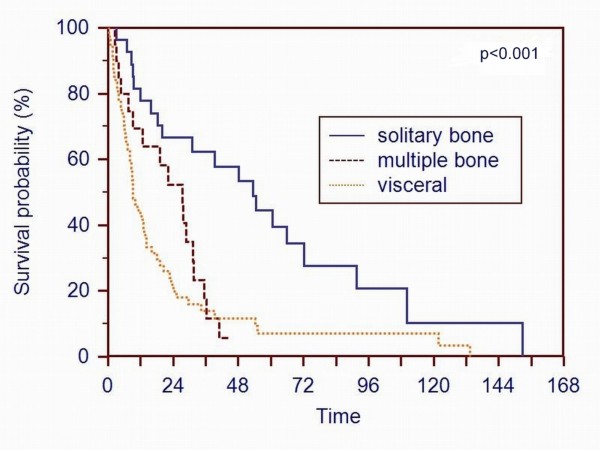
A Kaplan-Meier survival curve of patients based on the metastatic pattern shows that patients with solitary bone metastases had a better survival (p < 0.001) than patients with multiple bone metastases or additional visceral metastases.